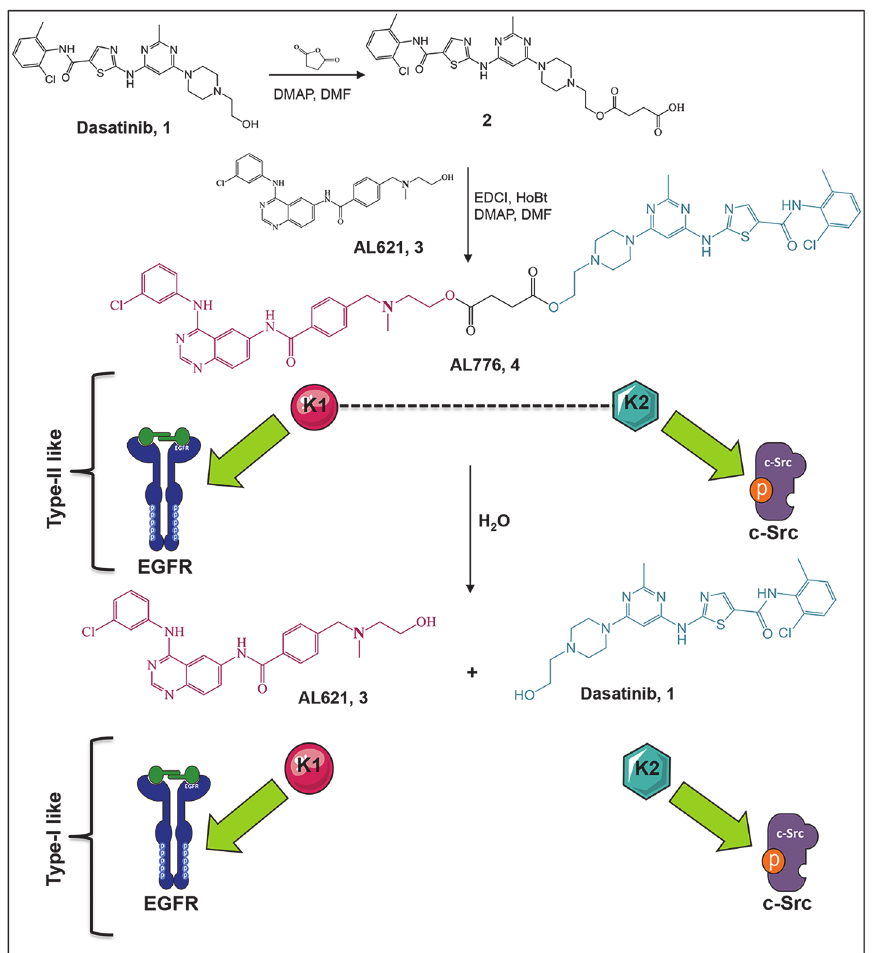
Fig 3. Synthesis and hydrolysis of AL776, the lead K1-K2 prototype targeting EGFR and c-Src. The synthesis of AL776 was carried out in our laboratory according to the steps indicated above. The resulting type III K1-K2 molecule is designed to undergo hydrolysis inside the cells and release a potent EGFR tyrosine kinase inhibitor (K1) termed AL621 and a potent c-Src tyrosine kinase inhibitor (K2) dasatinib (type I). AL776 is also capable of exerting its dual inhibitory property by directly interacting with each target as an intact molecule (type